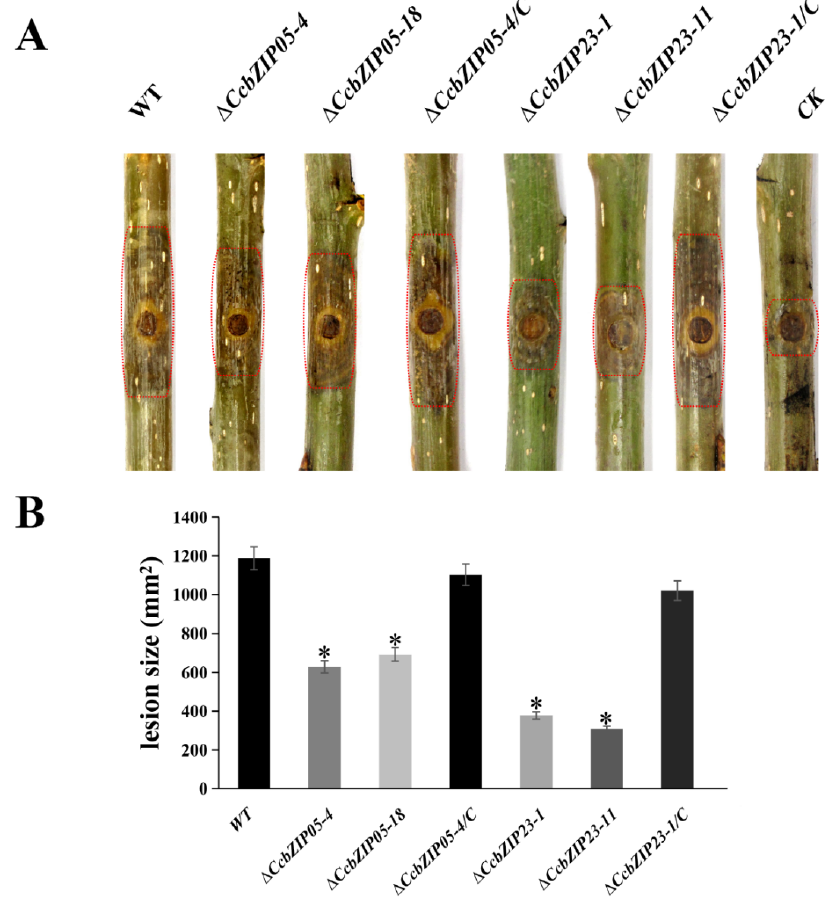
Figure 9. Pathogenicity test of Δ CcbZIP05 and Δ CcbZIP23 mutants on poplar twigs. ( A ) Infection symptoms on detached poplar twigs inoculated with the wild-type, gene deletion mutants, and complemented strains. The inoculated twigs were photographed at 6 dpi. CK represents twigs inoculated with PDA plugs after scalding. ( B ) Lesion areas were determined on the inoculated twigs. The asterisks on the bars indicate a significant difference between CcbZIP05 deletion mutants, CcbZIP23 deletion mutants, and the wild-type ( p < 0.05). In each experiment, 20 healthy poplar twigs were inoculated with wild-type, gene deletion mutants, and complementary strains, respectively. The experiment was repeated three times.